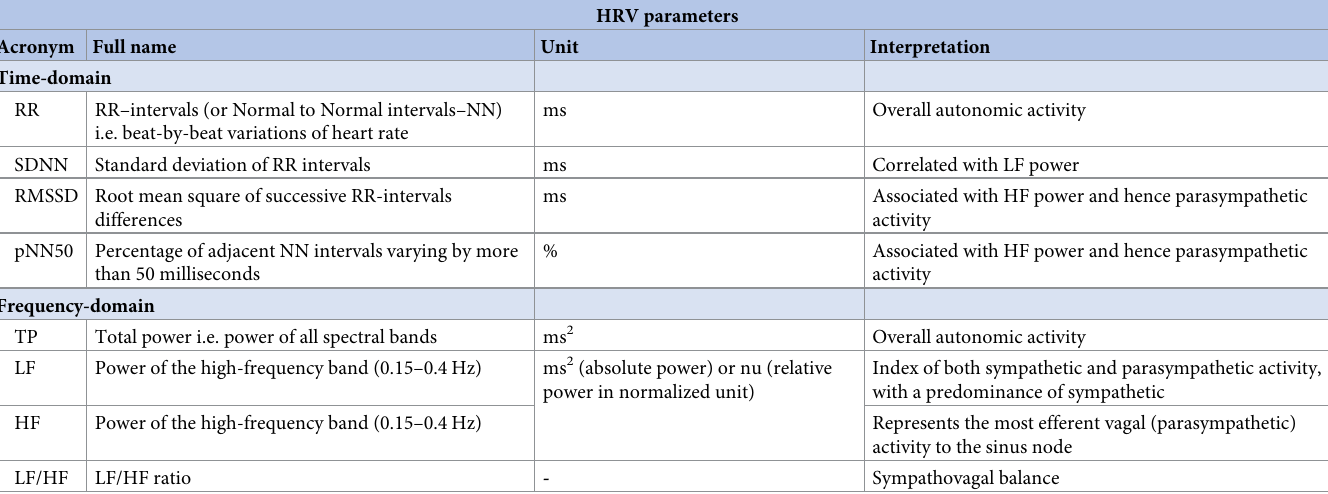
Table 1. Descriptive characteristics of HRV